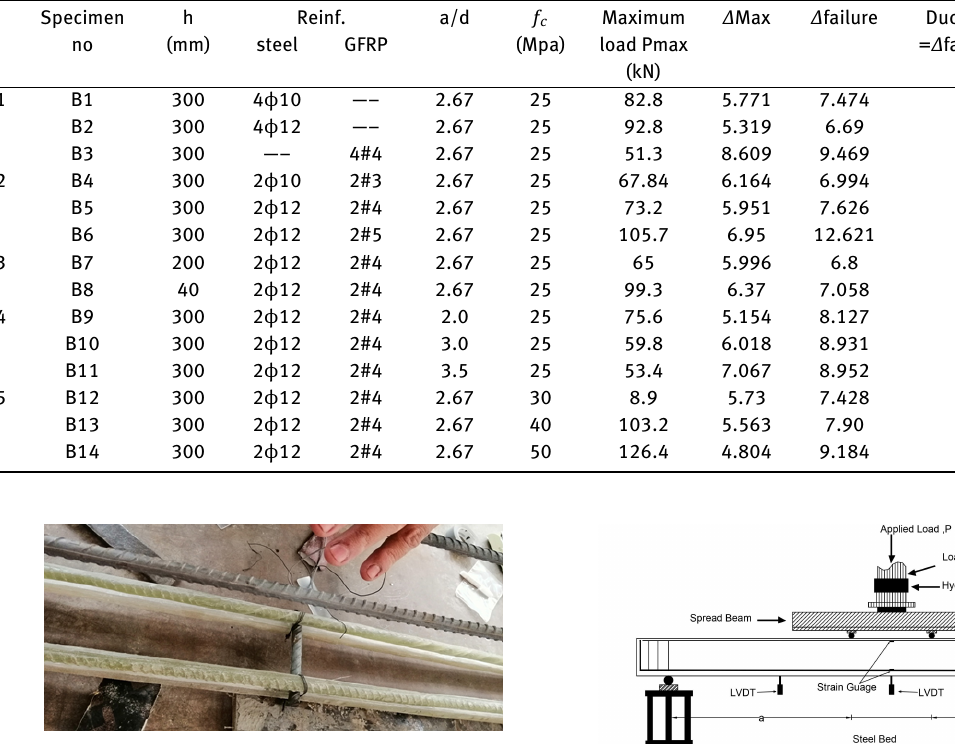
Table 2: The ductility index and area energy absorption of tested RC beams Specimen